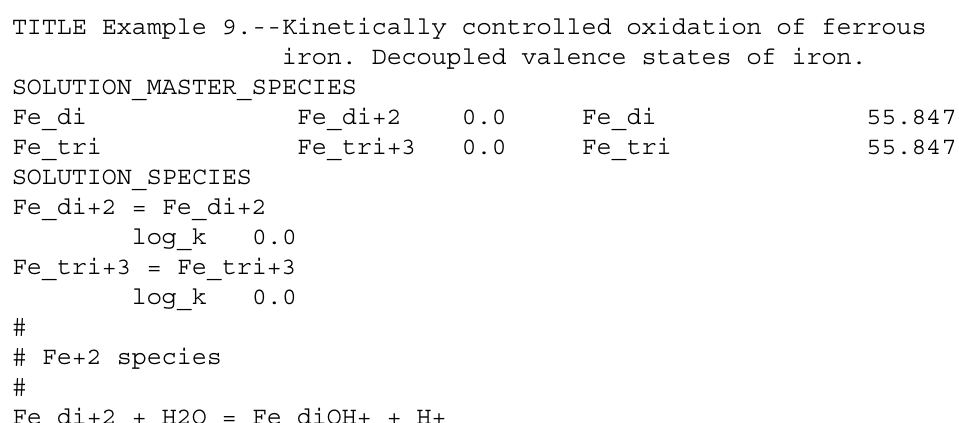
Table 28. Partial input file for example 9. TITLE Example 9.--Kinetically controlled oxidation of ferrous iron. Decoupled valence states of